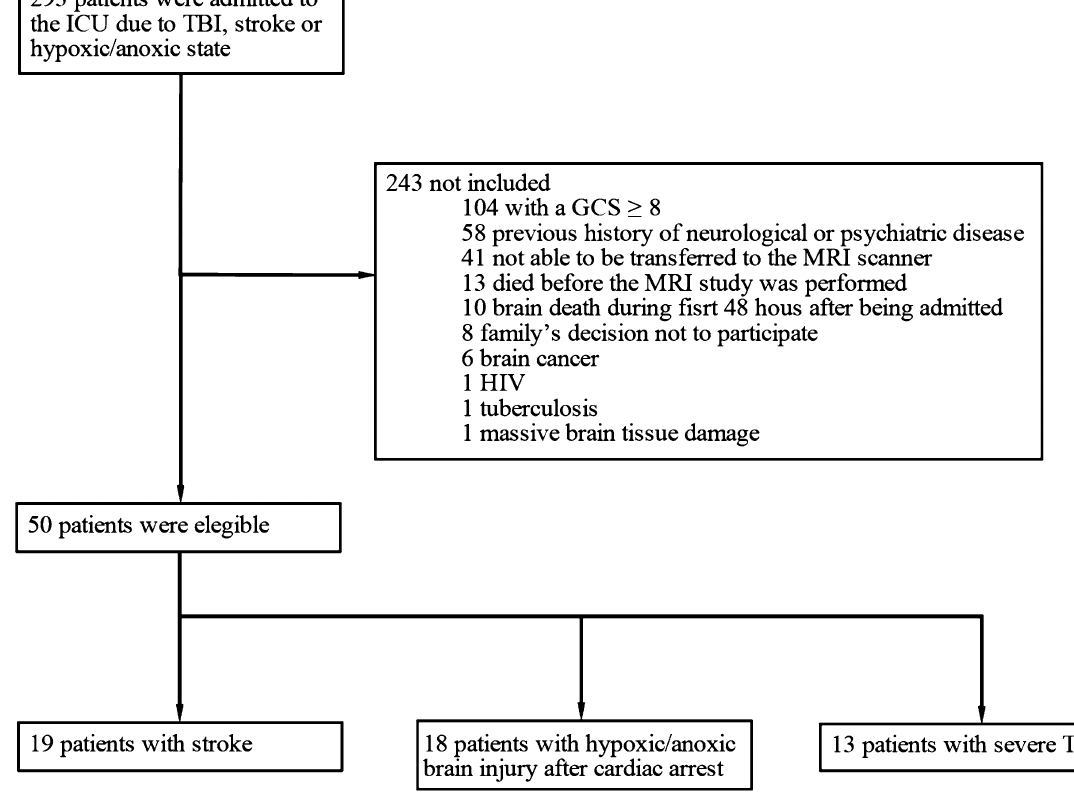
Figure 1. Description of the enrollment of patients in the